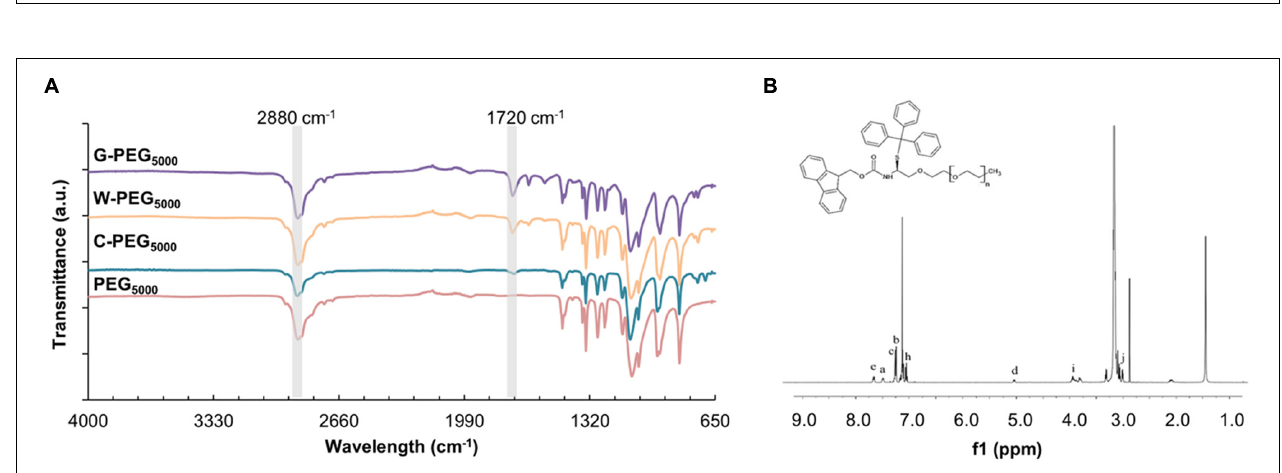
FIGURE 6 | Schematic illustration of the reactions involved in the preparation of the PEGylated SWNTs.